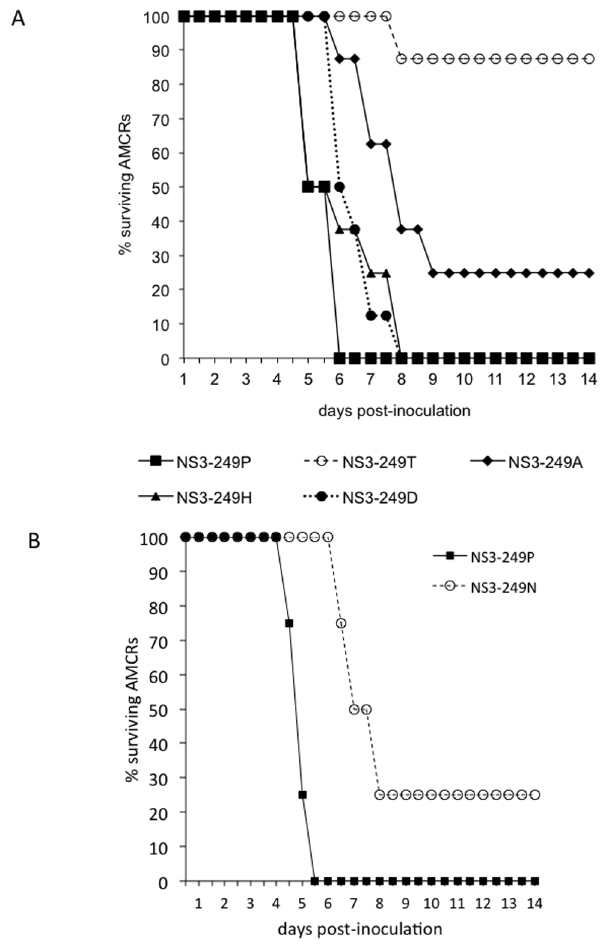
Figure 4. Viremia profiles of AMCRs inoculated with WN/IC NS3-249 mutants. (A) Mean daily viremias from AMCRs (n=8) from Colorado inoculated with WN/IC NS3-249 point mutants (NS3-249P, 249D, 249T, 249H, and 249A); (B) Mean daily viremias from 2012 captured AMCRs (n=4) inoculated with WN/IC NS3-249P and 249N mutants. Bars denote standard deviations from the mean.